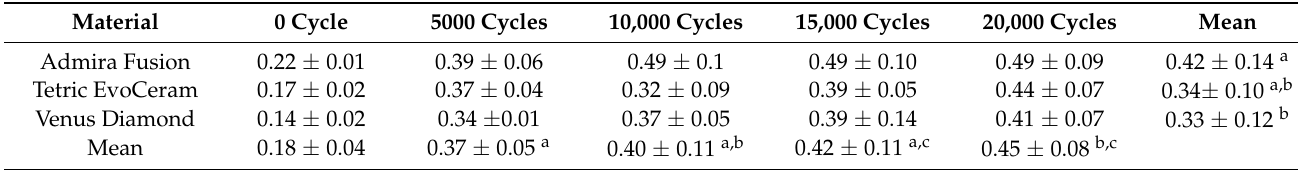
Table 2. Means and Standard deviations of Ra values in µ m for the composite materials after different numbers of toothbrushing cycles.